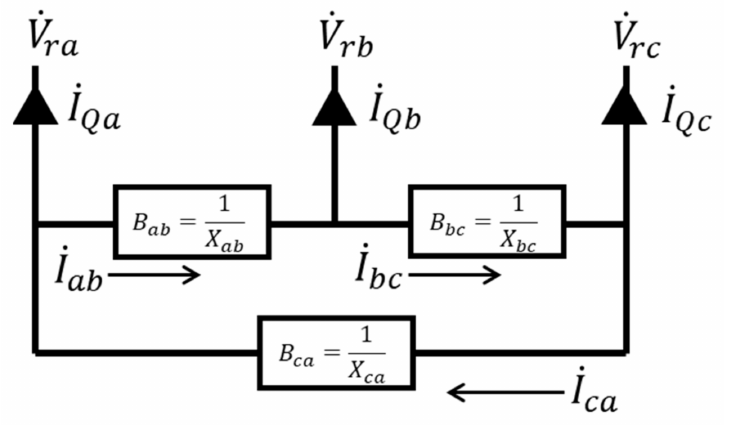
Figure 10. Single phase reactors connected to the receiving end of distribution